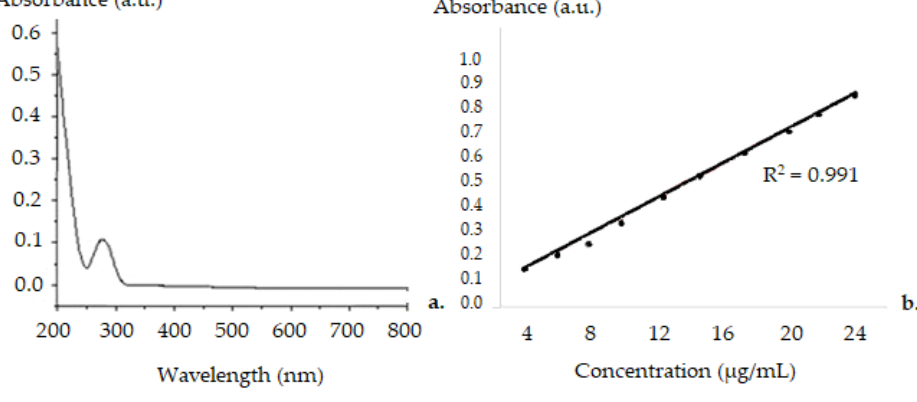
Figure 6. UV–vis Spectra for DCF in suspension ( a ) and calibration curve ( b Figure 6. UV – vis Spectra for DCF in suspension (a) and calibration curve (b).